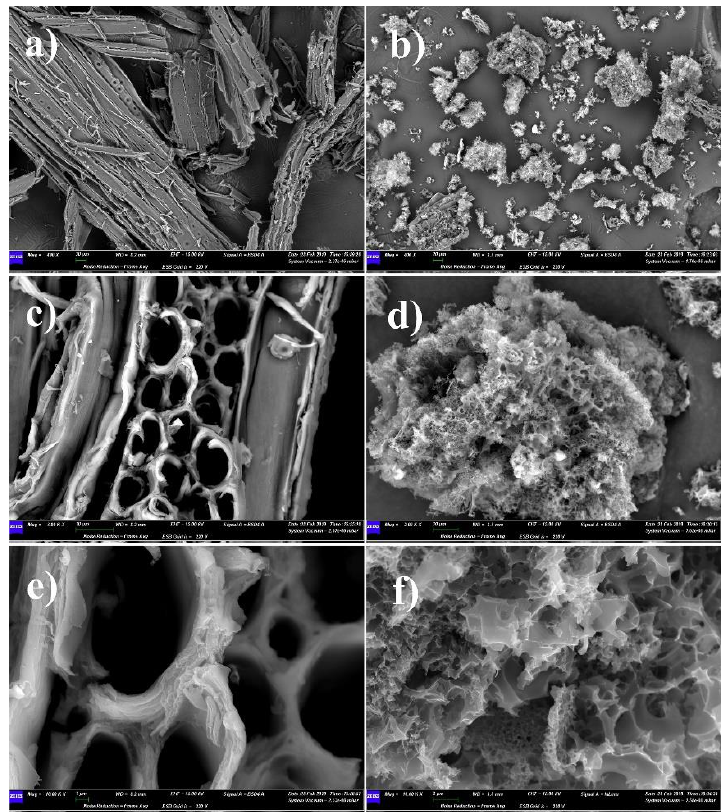
Figure 2. Scanning electron microscopy (SEM) images of HC_200_0 (left-hand side: ( a , c , d ) and HCA_200_0 (right-hand side: ( b ), ( d , f ) at different magnification: ( a , b ) 400×; ( c ) 3000×; ( d ) 2000×; ( e , f ) 10,000×.